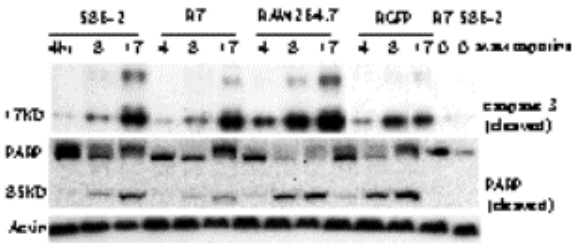
Fig. 1. Inhibition of apoptosis by LBA fusion